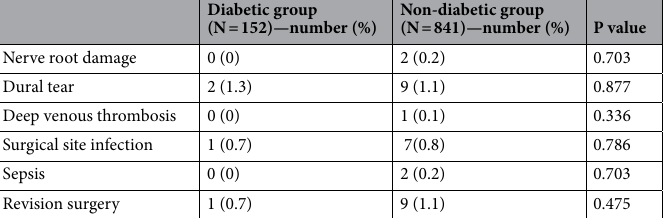
Non-diabetic group (N = 841)—number (%) P value